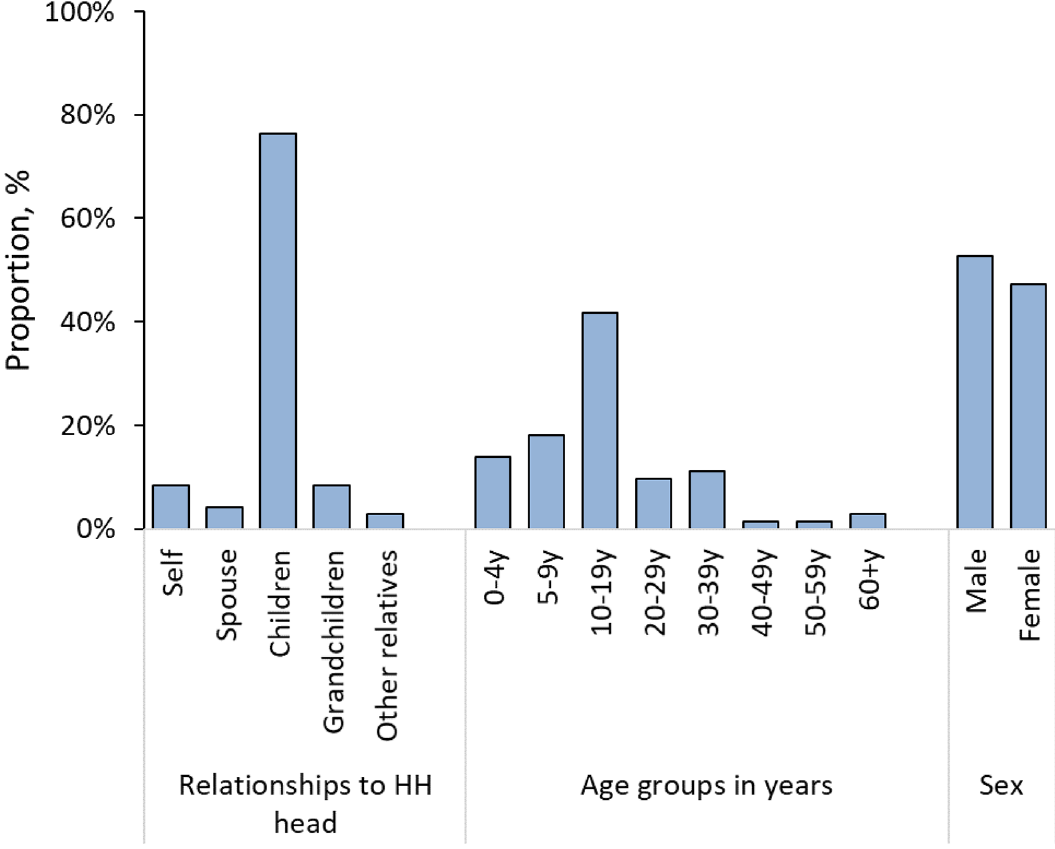
Figure 6. Distribution of 72 seronegative individuals by relationship to household (HH) head, age groups in yearsandsexfromthe98householdswithleastoneseropositivepersoninKiberaurbaninformalsettlement, Nairobi,